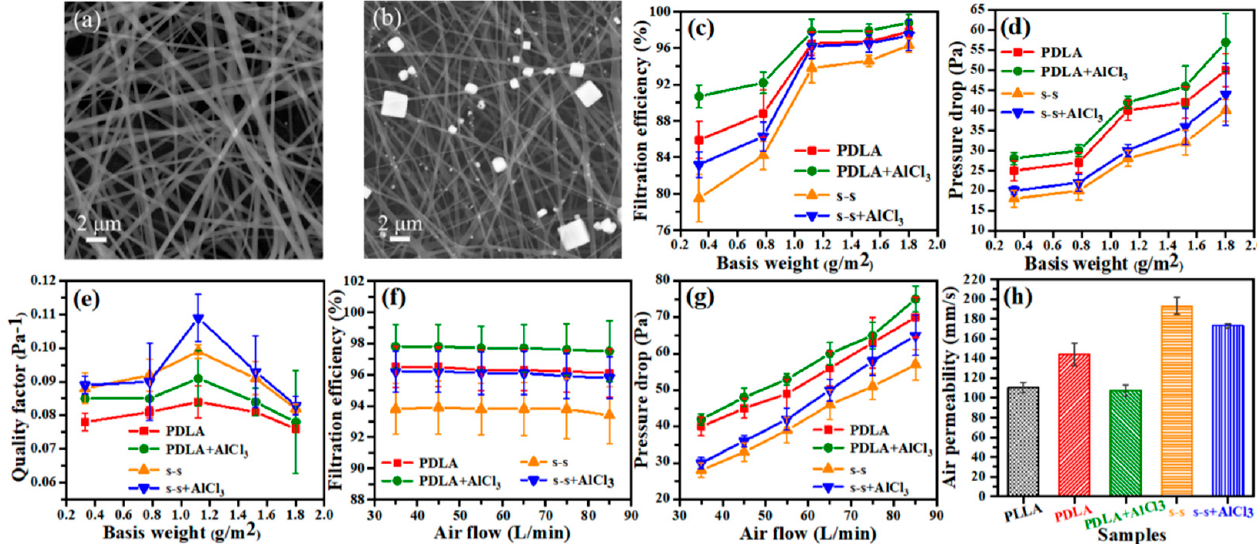
Figure 7. SEM images of the s-s+AlCl 3 nanofibers ( a ) before and ( b ) after filtration; ( c ) the filtration efficiency, ( d ) pressure drop, and ( e ) quality factor of single-spinning and side-by-side fibers before and after adding 1 wt% AlCl 3 under different basis weight conditions; ( f ) the filtration efficiency and ( g ) pressure drop of single-spinning and side-by-side fibers before and after adding 1 wt% AlCl 3 under different airflow conditions; ( h ) the air permeability performance of PLLA, PDLA, PDLA+AlCl 3 , s-s, s-s+AlCl 3 fiber membranes.